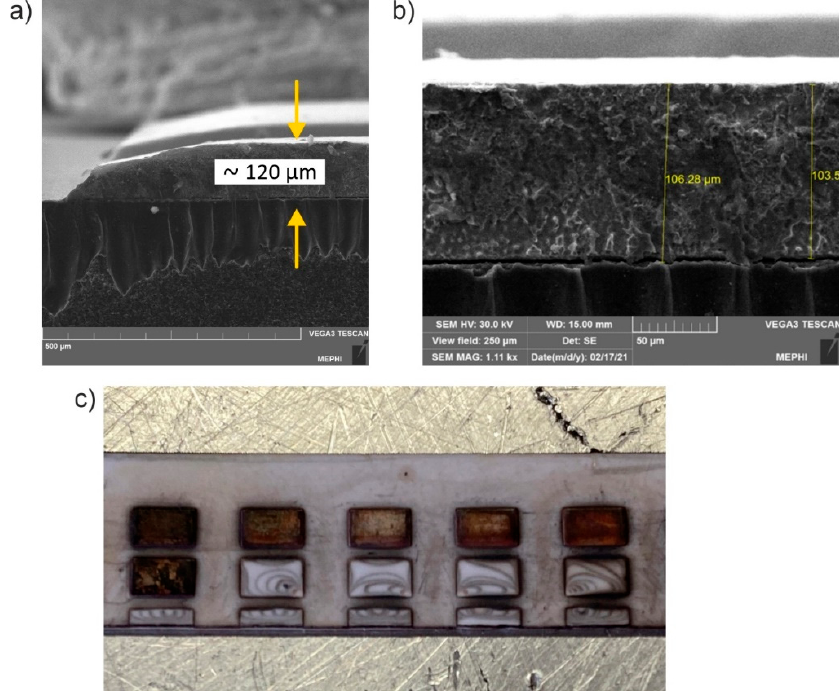
Figure 6. Copper film deposited on alumina substrate through a shadow mask: ( a ) SEM image of Cu island cross-section; ( b ) SEM image of the interface; ( c ) sample from Figure 5b after thermal tests.